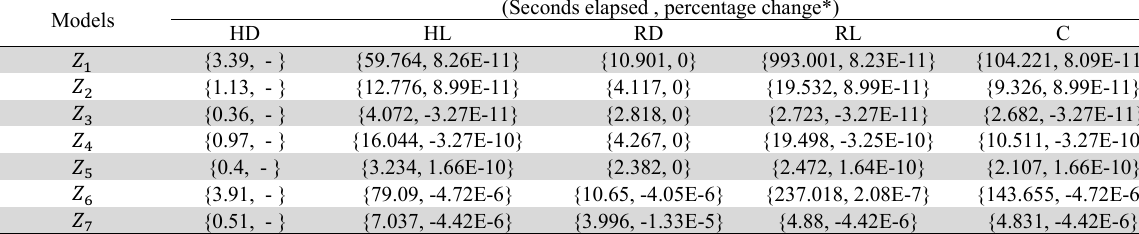
(cid:3404) (cid:1870) (cid:3404) (cid:1872) (cid:3404) 0 and (cid:1846) (cid:2869) (cid:2870) (cid:2869)